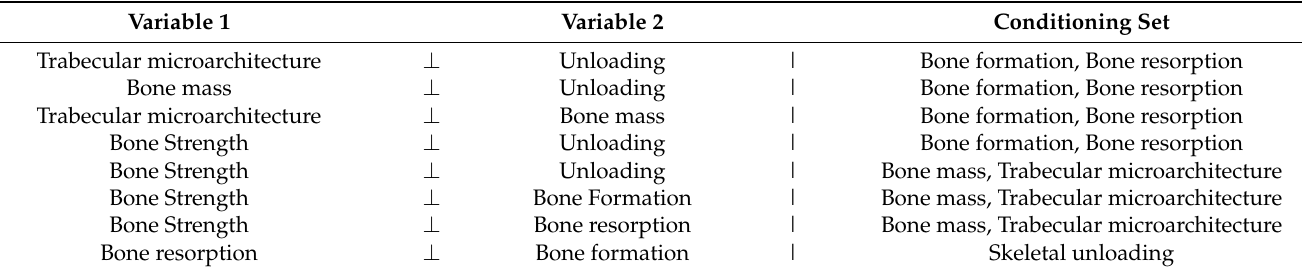
Table 3. Conditional independencies of the DAG in Figure